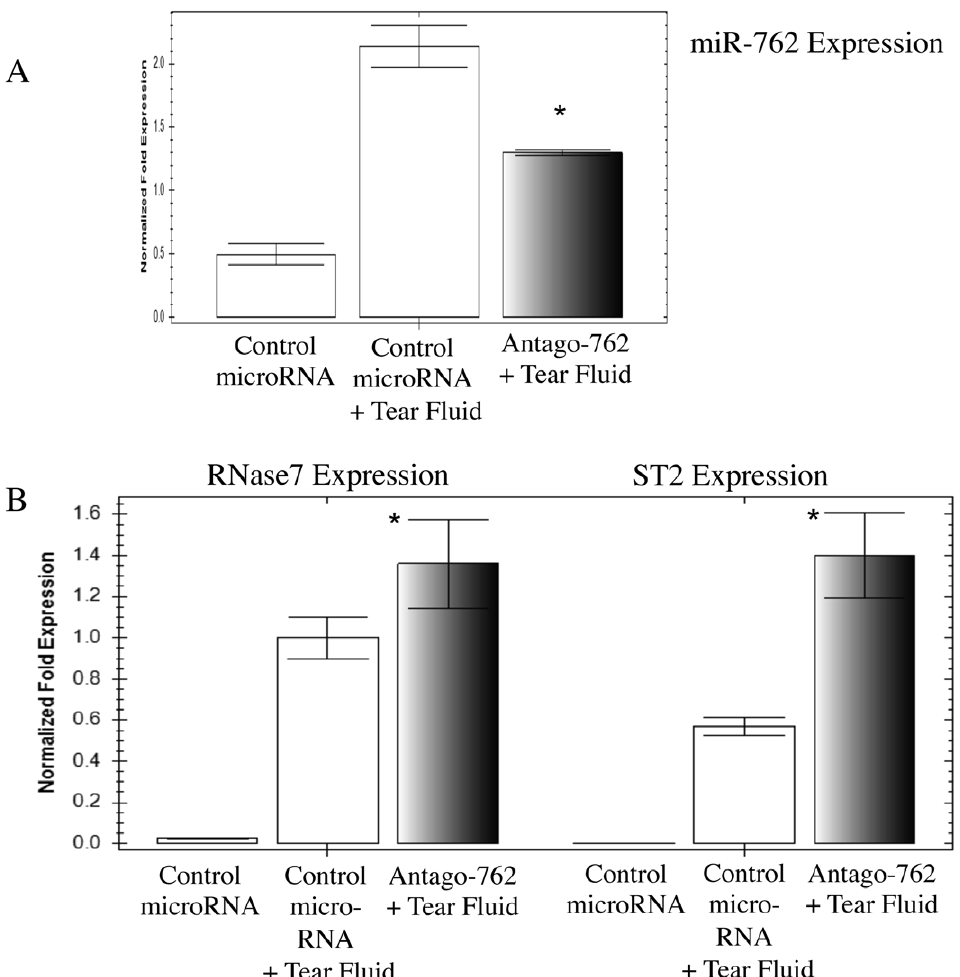
Figure 4. Tear fluid induction of miR-762 negatively regulates RNase7 and ST2 gene expression. a Tear fluid induction of miR-762 expression in corneal epithelial cells was reduced by the antagomir of miR-762. b The antagomir of miR-762 enhanced tear-induced expression of RNase7 and ST2 mRNA compared to control (scrambled) antagomir suggesting that tear-induced miR-762 expression negatively regulates these innate defense genes. RT-PCR was used to measure gene expression at 48 h after transfection (see Methods). (* p , 0.05, t-Test versus tear-treated scrambled controls).